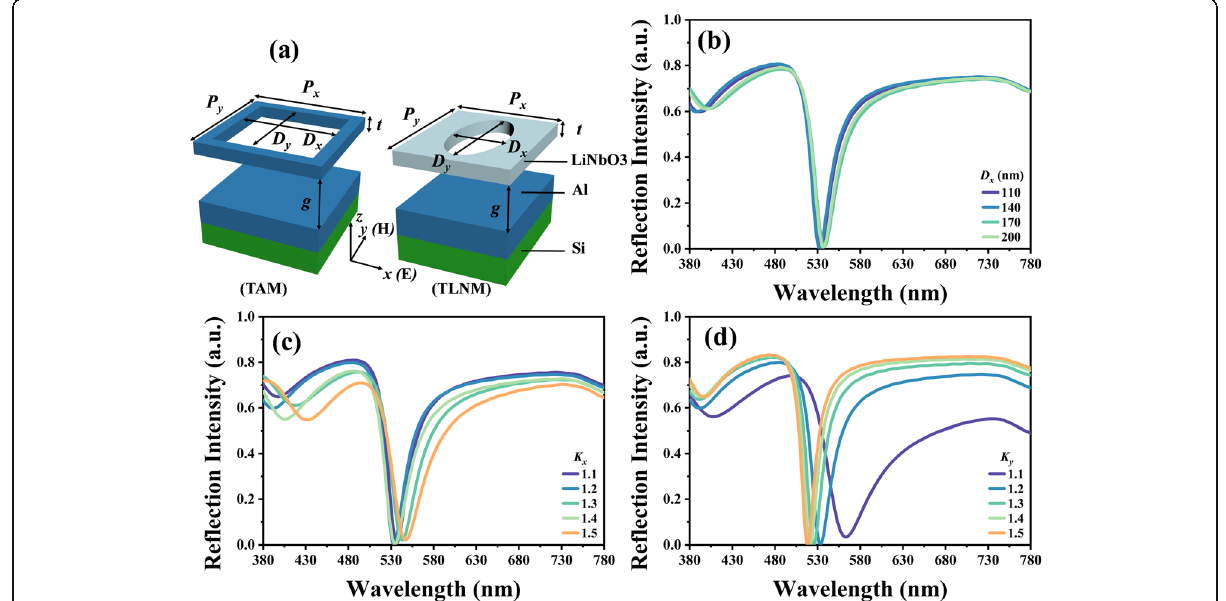
Fig. 1 a Schematic drawings of TAM and TLNM. b – d The reflection spectra of TAM with different ( b ) D x , ( c ) K x , and ( d ) K y